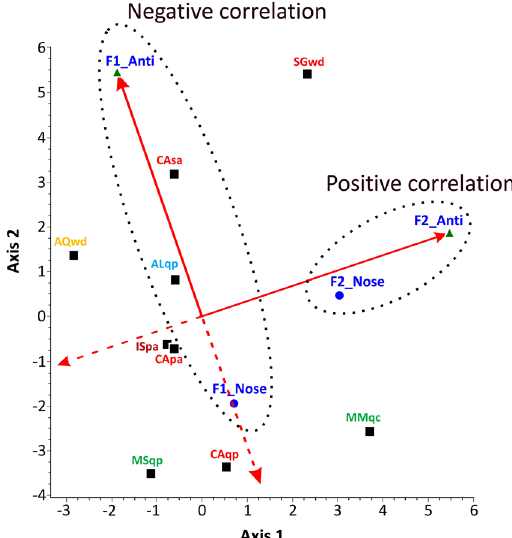
Figure 5. Triplot from RDA. The diagram displays three kinds of points: electronic nose data (circles markers), truffle samples (squares markers) and antioxidant parameters (triangles markers). The correlation of the antioxidant parameters with the RDA axes is represented by the length and directions of the red arrows. The truffle samples showing a high correlation with a given antioxidant parameter will be close to the position of the data. SMwd sample was not included because Nose data were not available. Nose = Electronic Nose; Anti = Antioxidant